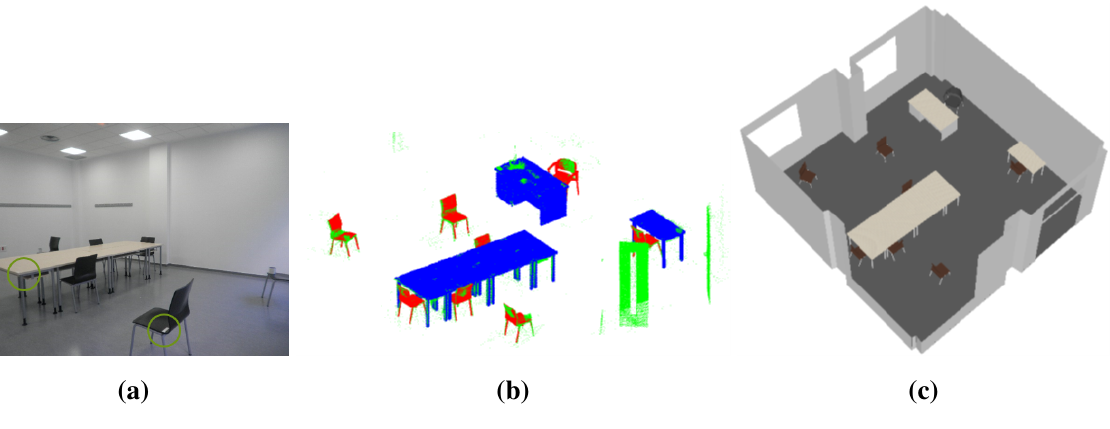
Figure 3. ( a ) Tags attached to pieces of furniture in an inhabited interior; ( b ) pieces